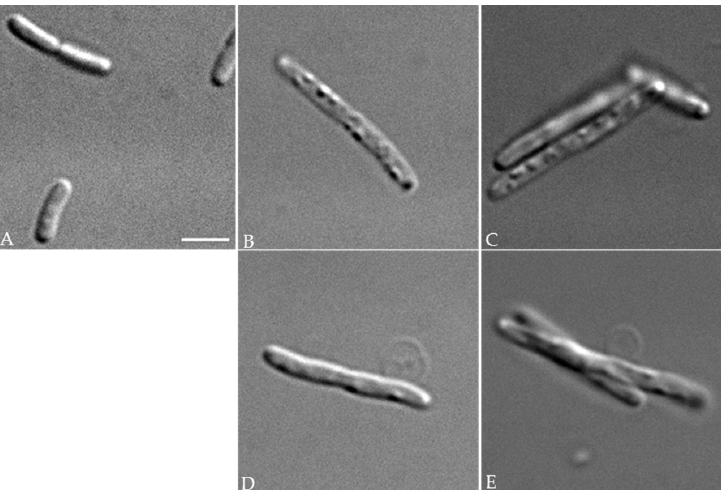
Figure 3. Morphology of E. coli strains. Optical micrographs of exponentially ‐ growing control FB8